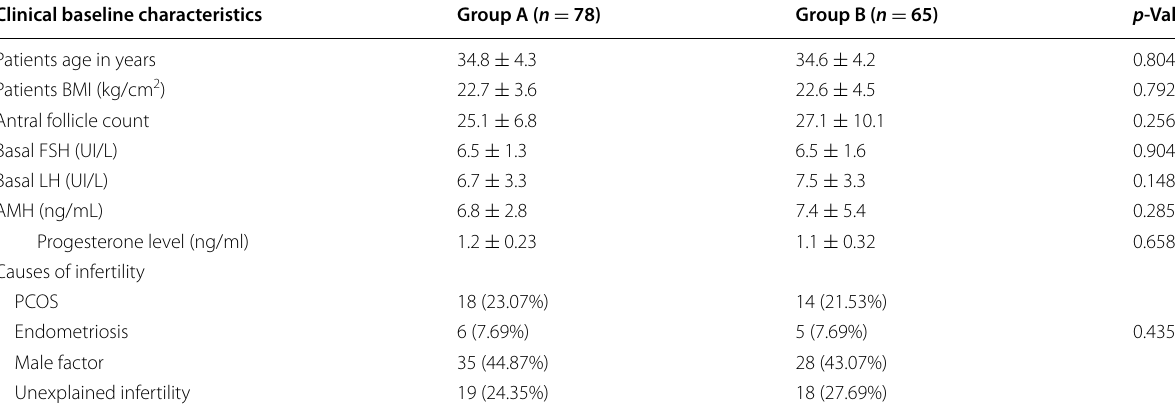
Data are presented as mean (SD), number, and proportion (%). BMI , body mass index; FSH , follicle-stimulating hormone; LH , luteinizing hormone; AMH , anti-Mullerian hormone; PCOS , polycystic ovarian syndrome